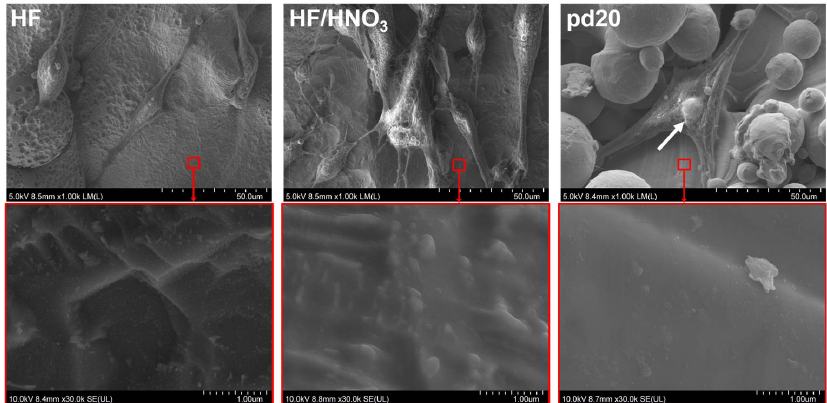
Figure 7. hMSCs under SEM microscope spreading after 1 day of culture on the polished (HF and HF/HNO 3 solutions) and unpolished (45 W laser power, 40 µs exposure time, 20 µm point distance) titanium discs. Red squares indicate area of the samples which are magnified to show sample topography and are depicted on images below.